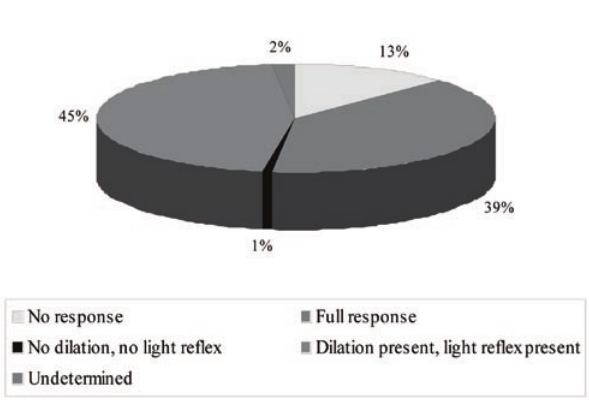
Figure 1: Distribution of cycloplegic response in sample